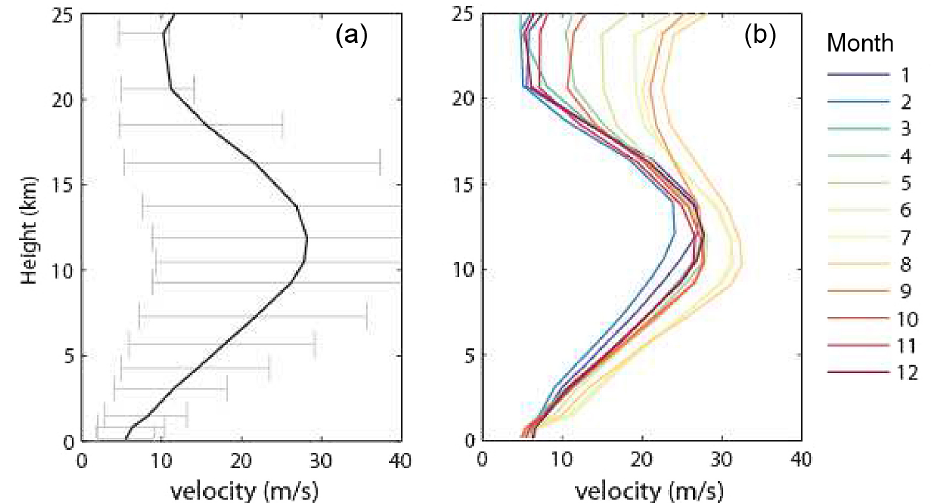
Figure B2. Statistical analysis of the wind velocity based on the NOAA NCEP/NCAR Reanalysis database for the period 2000–2015: (a) median value and standard deviation and (b) median value for each month; see Fig. 8 of main text for analysis of wind